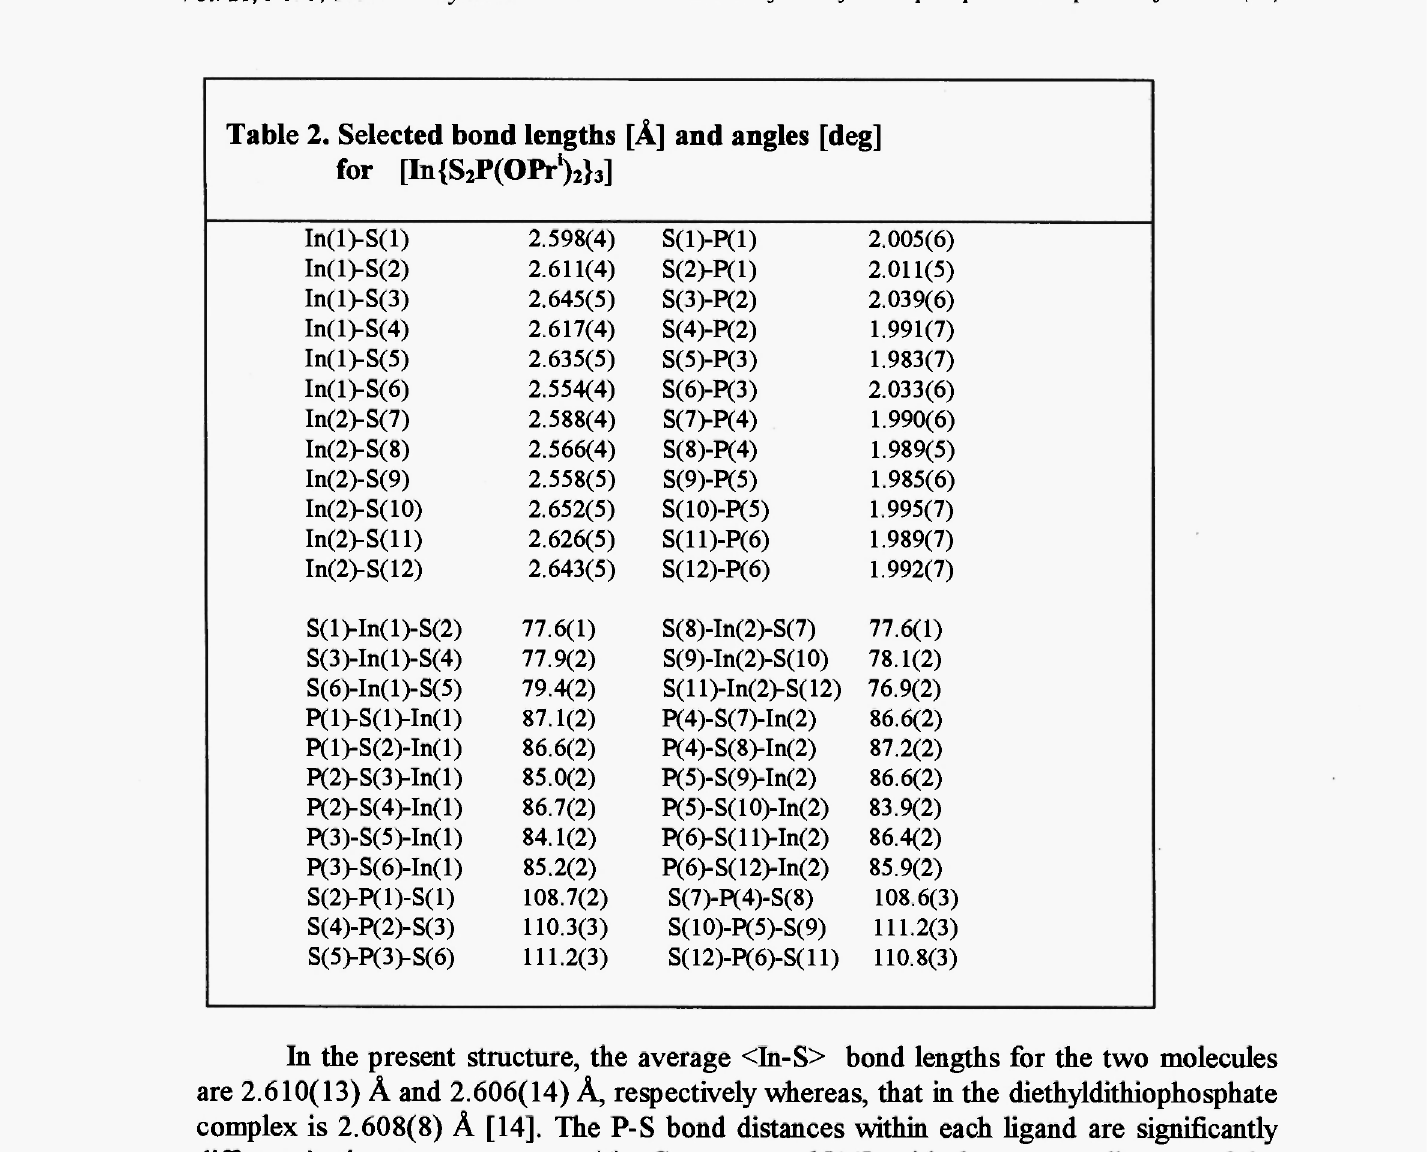
Table 2. Selected bond lengths [Ä] and angles [deg]